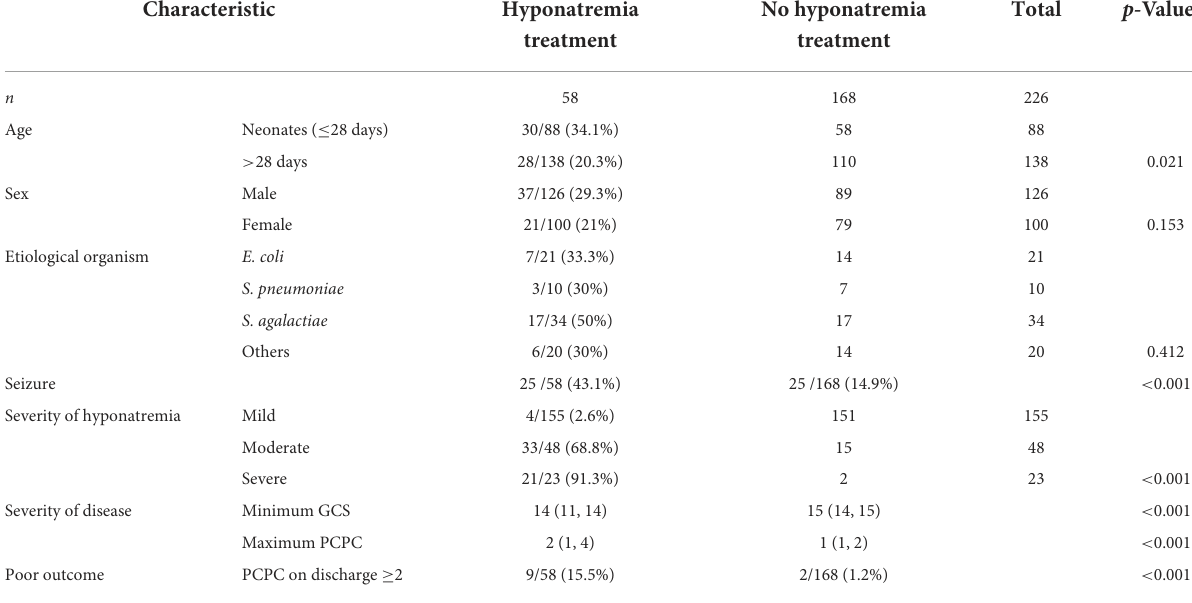
TABLE 1 Characteristics of patients with hyponatremia.